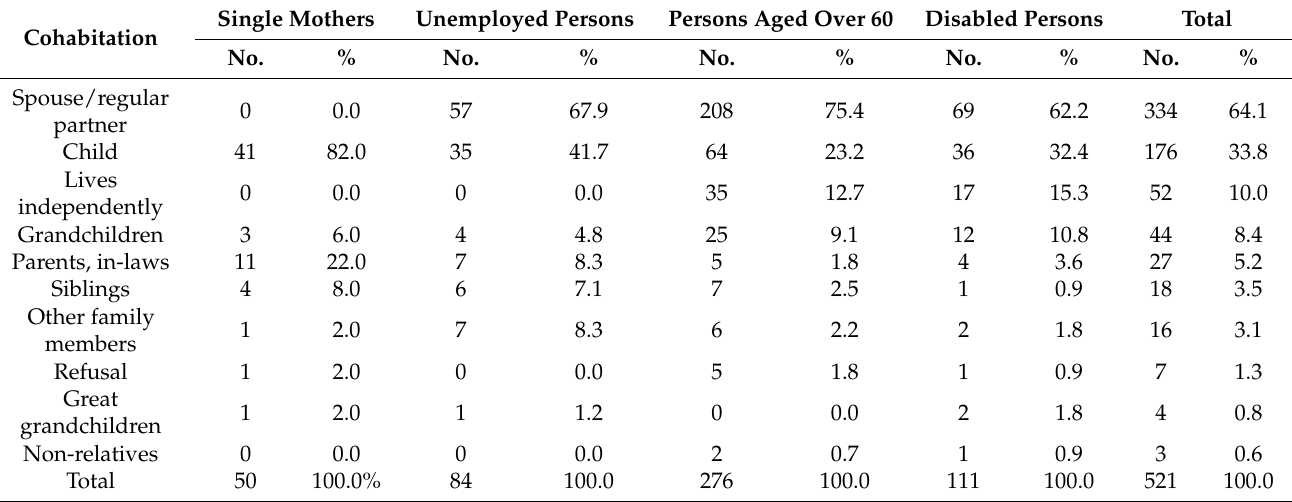
Table 8. Cohabitation with other people by social status of the respondents ( n = 521).